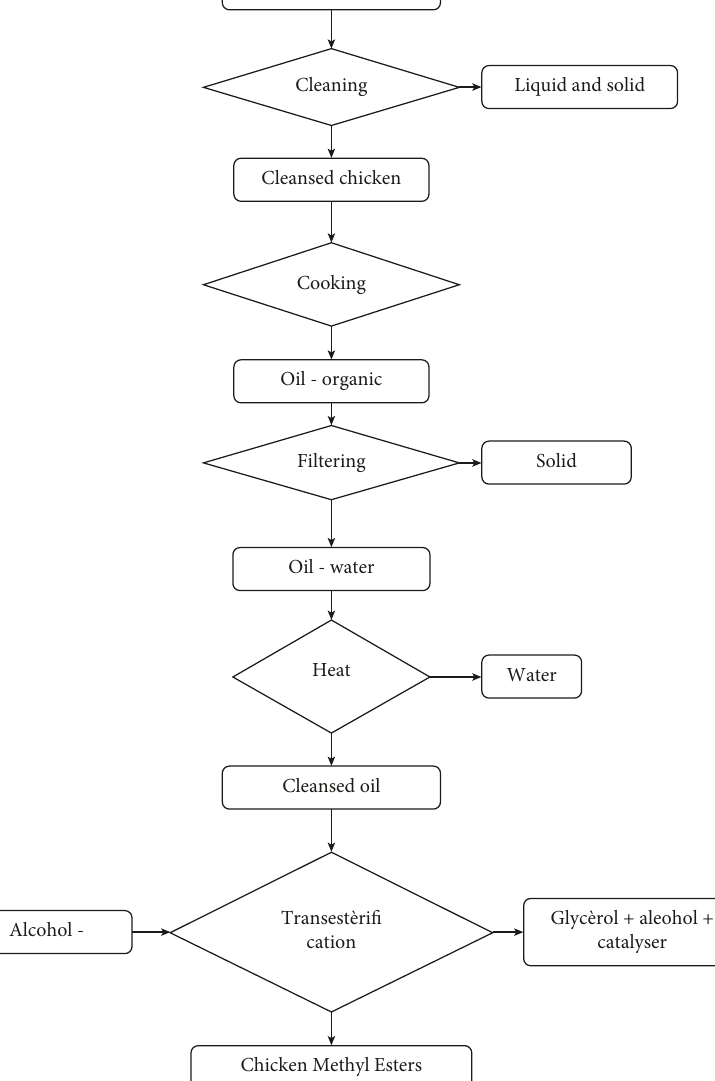
Figure 3: Biodiesel production protocol from fatty chicken residues.